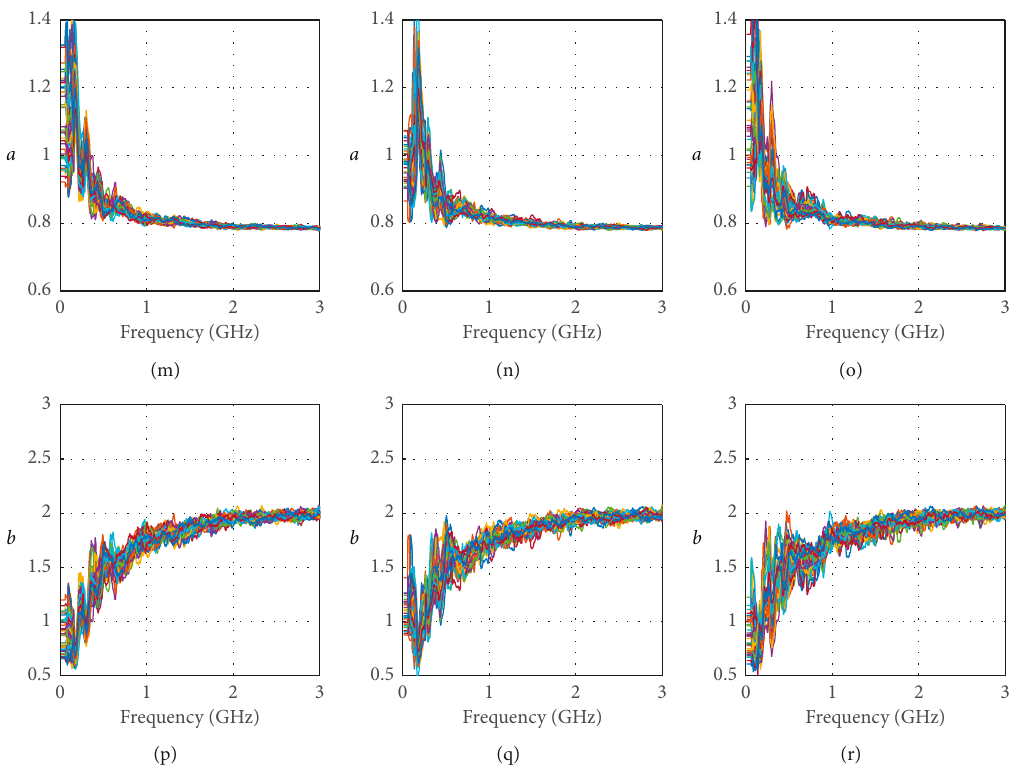
Figure 2: Estimated ( a,b ) at different heights; 36 curves are overlaid. (a)–(f) are the estimated ( a,b ) at the height of 30cm for the x -polarized, y -polarized, and z -polarized probes, respectively; (g)–(l) are the estimated ( a,b ) at the height of 62cm for the x -polarized, y -polarized, and z - polarized probes, respectively; (m)–(r) are the estimated ( a,b ) at the height of 98cm for the x -polarized, y -polarized, and z -polarized probes,